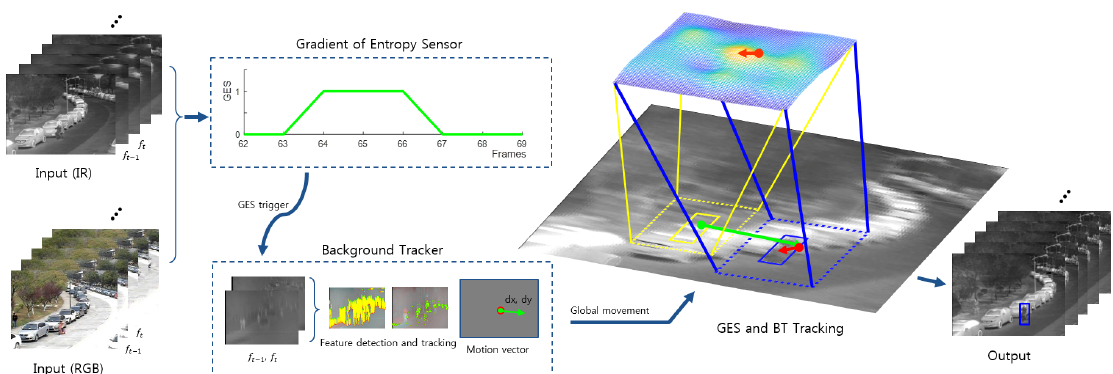
Figure 2. An overview of the proposed method. The IR and RGB images are used in the gradient of the entropy sensor ( GES ) module to determine when camera motion happens. Then, the background tracking (BT) module is used to estimate global movement on the consecutive IR images. Estimation of the global movement is used to translate the position of the search